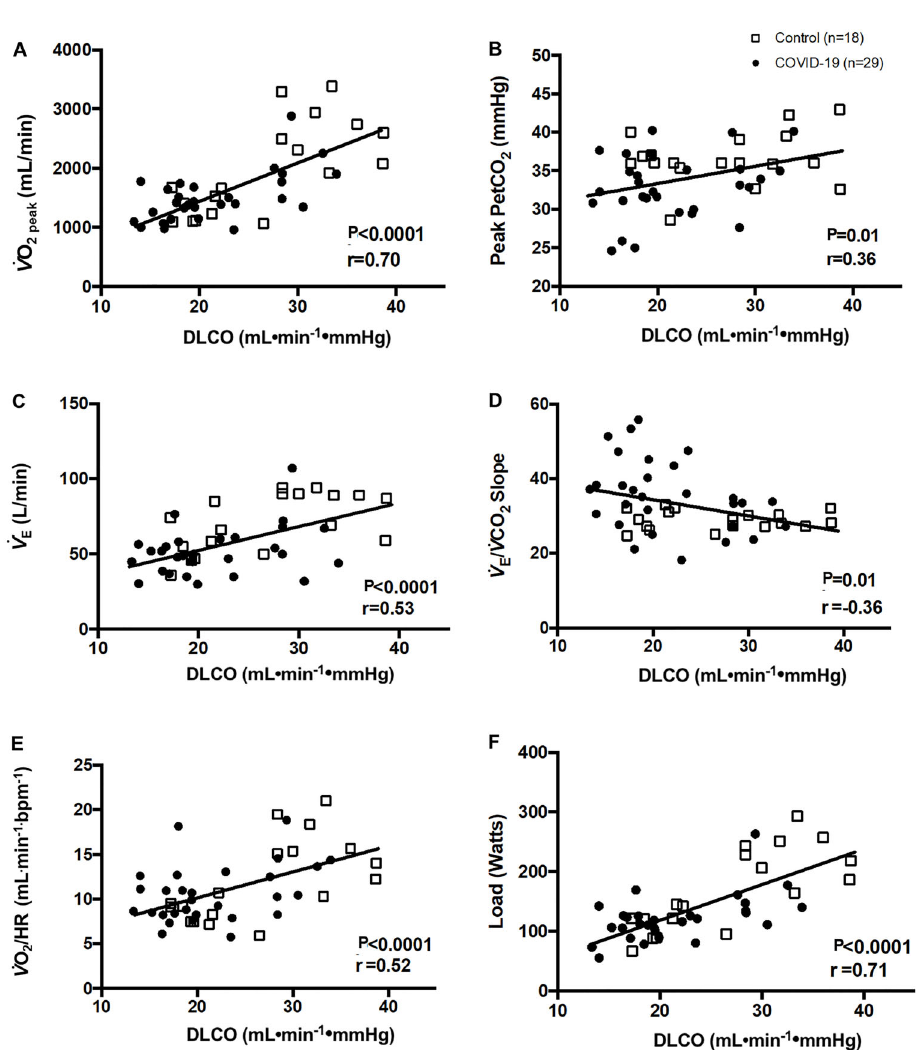
Figure 3. DLCO response pro fi les and their relationship with selected variables at cardiopulmonary exercise testing peak. Pearson ’ s correlation analysis was performed to investigate correlations between variables. DLCO: carbon monoxide diffusing capacity; oxygen uptake; P ET CO 2 peak : end-tidal pressure for carbon dioxide; ventilation and carbon dioxide output;